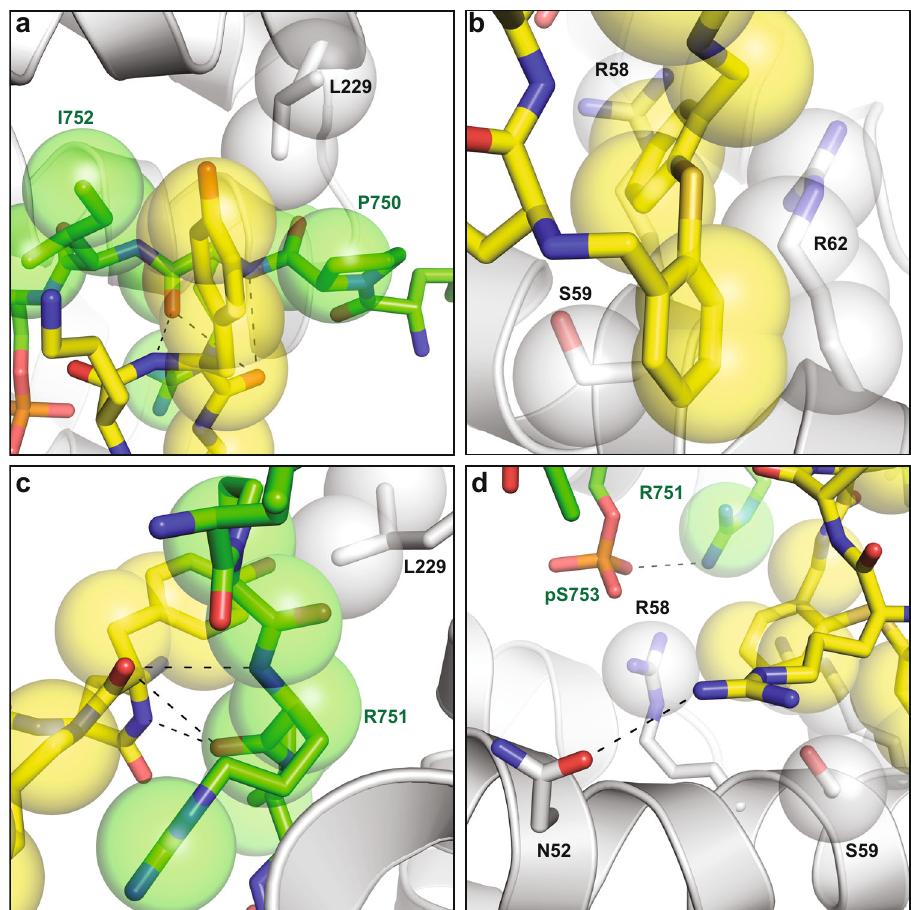
Fig. 4 Detailed view of the interactions of CY007424 binding to the complex of 14-3-3 β and CFTRpS753pS768. a Interaction of the tyrosine moiety of CY007424 (yellow sticks and semi-transparent spheres) with P750 to I752 of the CFTRpS753pS768 peptide and L229 of 14-3-3 β . b Binding of the thio- bis-phenyl part of the core ring of CY007424 to the hydrocarbon part of R58, S59, and R62 of 14-3-3 β . c Polar interactions of the main-chain nitrogens and carbonyls of the tyrosine moiety of CY007424 and R751 of CFTRpS753pS768. d Polar contact of the guanidinium group of CY007424 with N52 of 14-3-3 β . In the presence of CY007424, the sidechain of R751 of CTRFpS753pS768 becomes visible and establishes a polar contact with the phosphate of